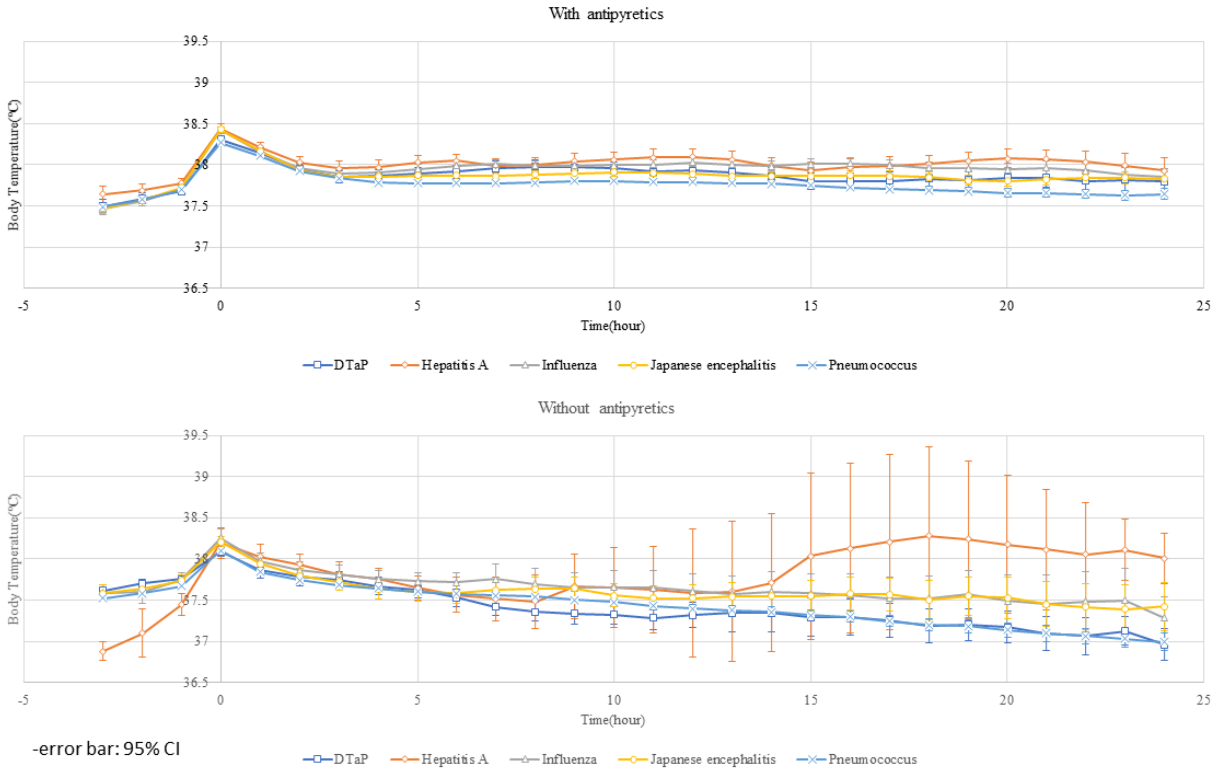
Figure 6. Body temperature graph over time for each vaccine showing the effects of antipyretic administration. The empty circle indicates the mean; the error bar represents a 95% confidence